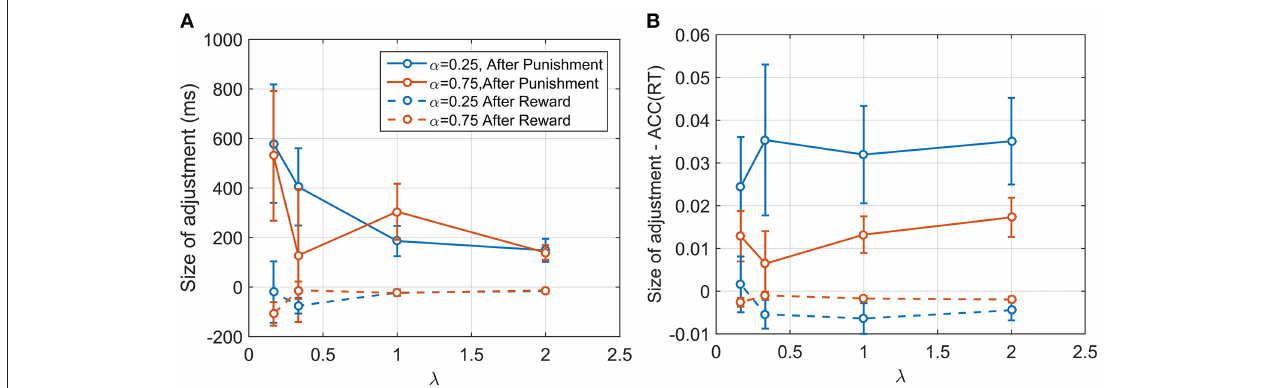
FIGURE 7 | (A) Size of the adjustment in ms after a punishment and after a reward for α and λ .The adjustment is larger after a punishment, and seems to be dependent on the conditions itself. (B) Size of adjustment in terms of ACC ( RT ) . As before, the adjustment is larger for punishment. Contrary to what shown in (A) , the plot reveals that the size of adjustment is dependent on α and more weakly on λ . It is plausible that participants were adjusting their accuracy by a certain proportion, and in so doing changed RT depending on λ .